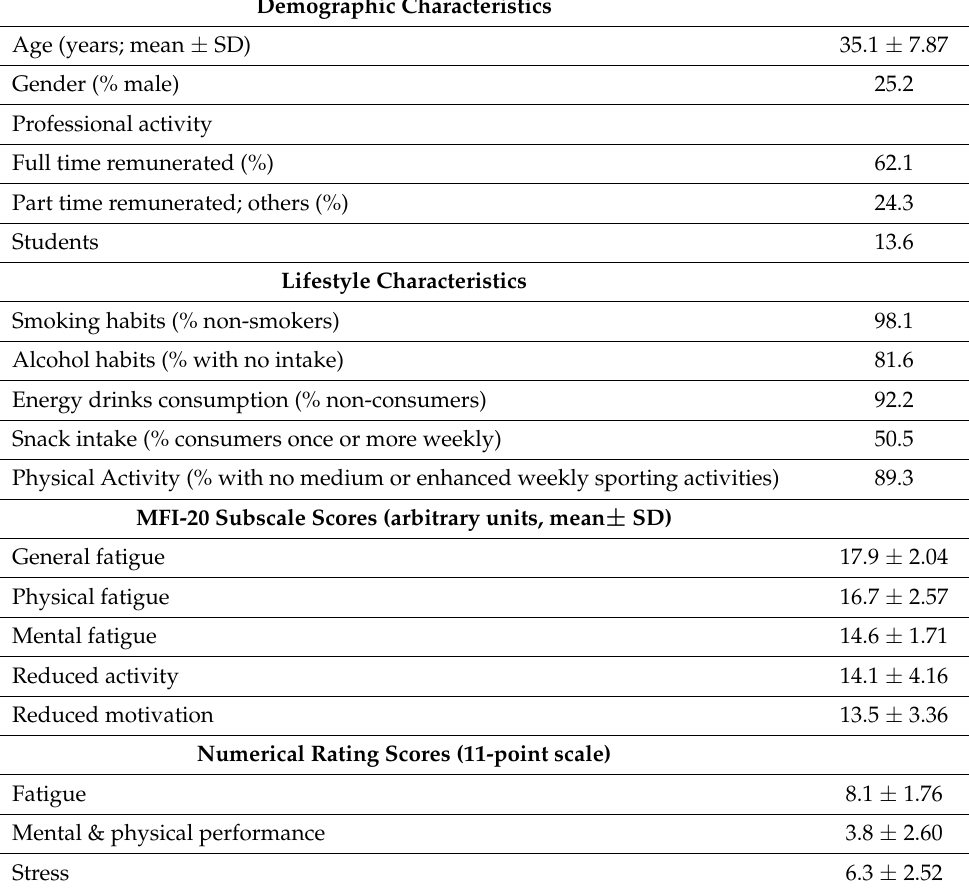
Table 1. Baseline characteristics of subjects ( n =